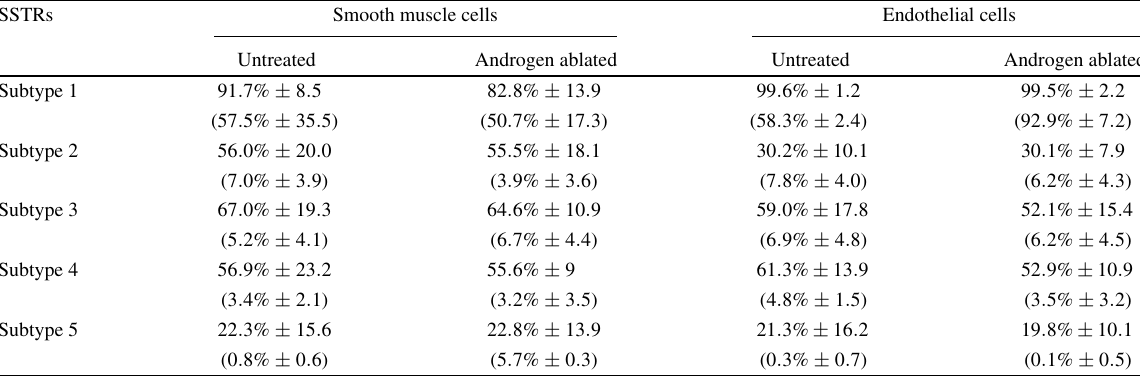
Percentages (mean ± standard deviation) of smooth muscle and endothelial cells with positive cytoplasmic